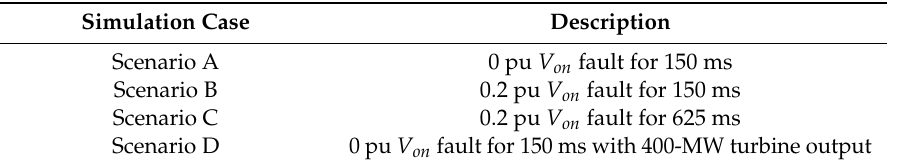
Table 4. Simulation